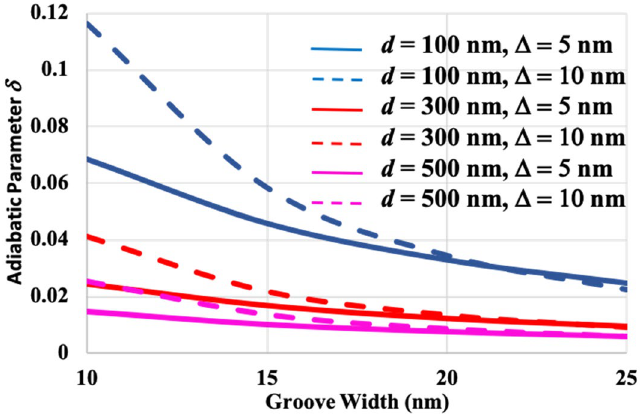
Figure 3. Theoretical relationship between the adiabatic parameter ( δ ) and groove width ( w ) as a function of groove-to-groove separation ( d ), and gradient in groove width ( ∆ ). Note that higher values of d and lower values of ∆ lead to smaller values of δ . The smaller the δ, the better the adiabatic mode transformation between the